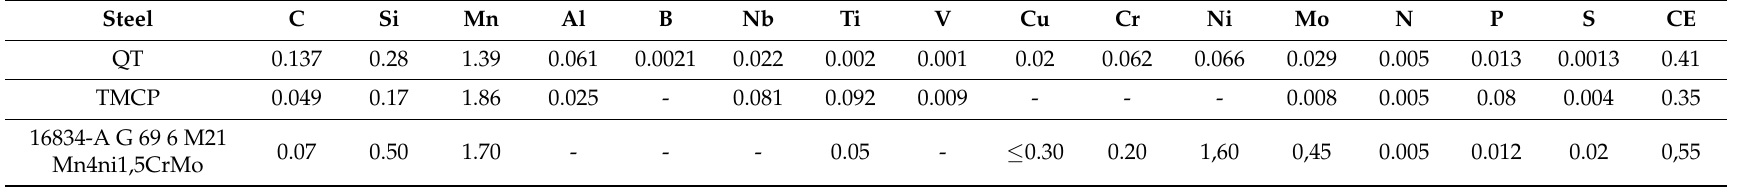
Table 1. The chemical composition of the quenching and tempering (QT), thermo-mechanically controlled process (TMCP) steels, welding wire (wt.%), and the carbon equivalent